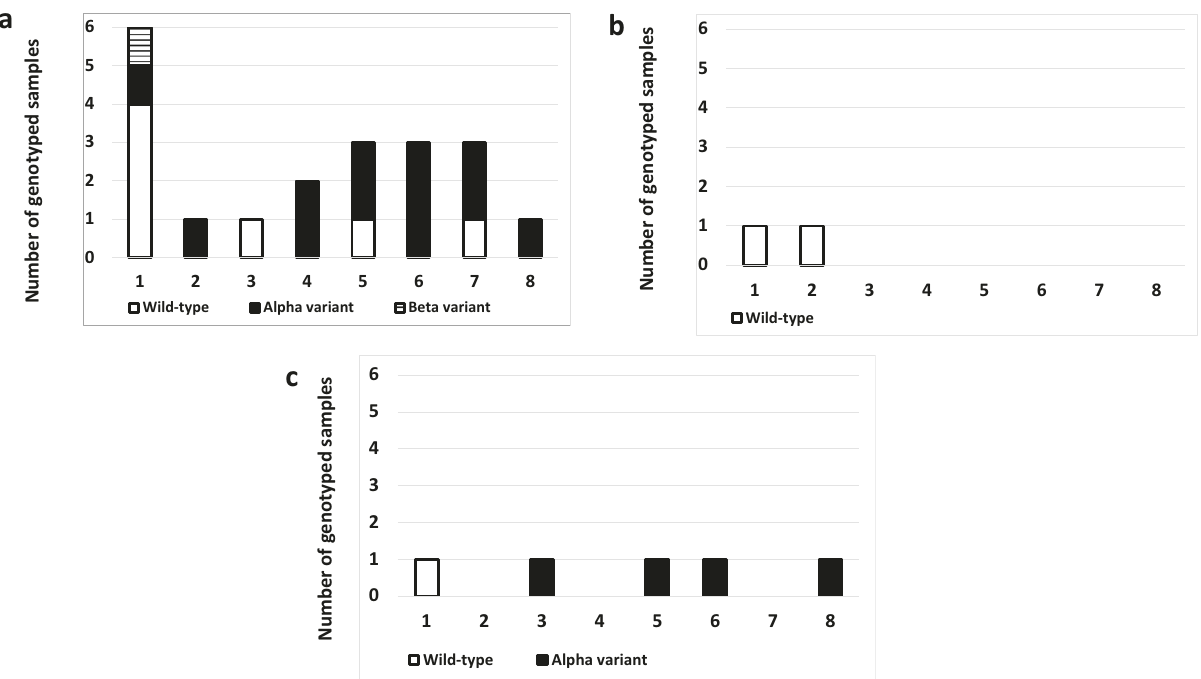
Fig. 5 Number of wild-type virus and variants of concern identi fi ed over time in function of the vaccine status. a Non-vaccinated workers. b One-dose vaccinated workers. c Two-dose vaccinated workers. Legend: W,